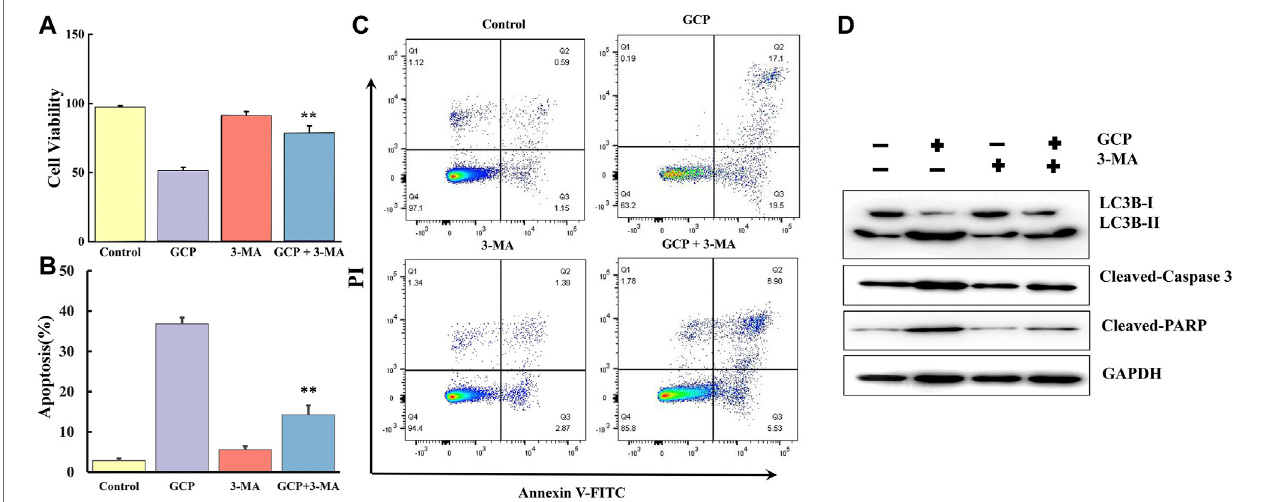
FIGURE 7 | Inhibition of autophagy suppresses apoptosis induced by GCP. HeLa cells were preincubated with or without 3-MA for 2 h, then treated with GCP (1500 nM) for24 h. (A) The CCK8 assay wasused tomeasure thecell viability. (B) Thelevels ofLC3, Cleaved-caspase 3,Cleaved PARP weredetectedby western bolt analysis. (C, D) Detection of apoptosis by fl ow cytometry. Each bar represents as mean ± SD from three independent experiments. ** p < 0.01 vs